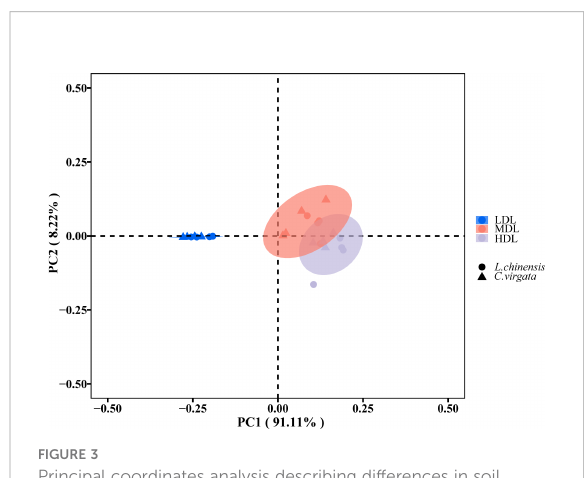
FIGURE 3 Principal coordinates analysis describing differences in soil extracellular enzyme activity (nmol g − 1 soil h − 1 ) and stoichiometry among three degraded levels. (LDL, lightly degraded level; MDL, moderately degraded level; HDL, highly degraded level; L. chinensis , Leymus chinensis ; C. virgata , Chloris virgata ).